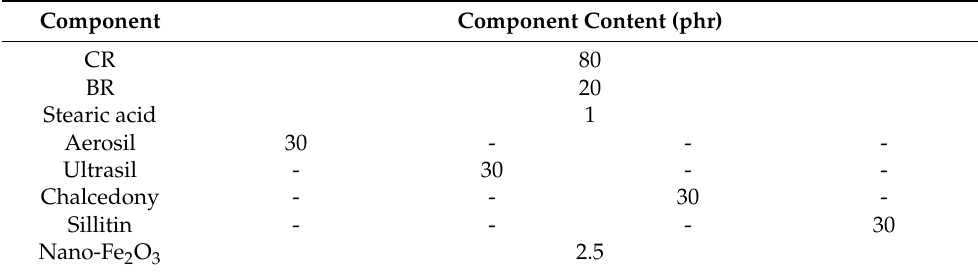
Table 3. Formulation of the elastomeric